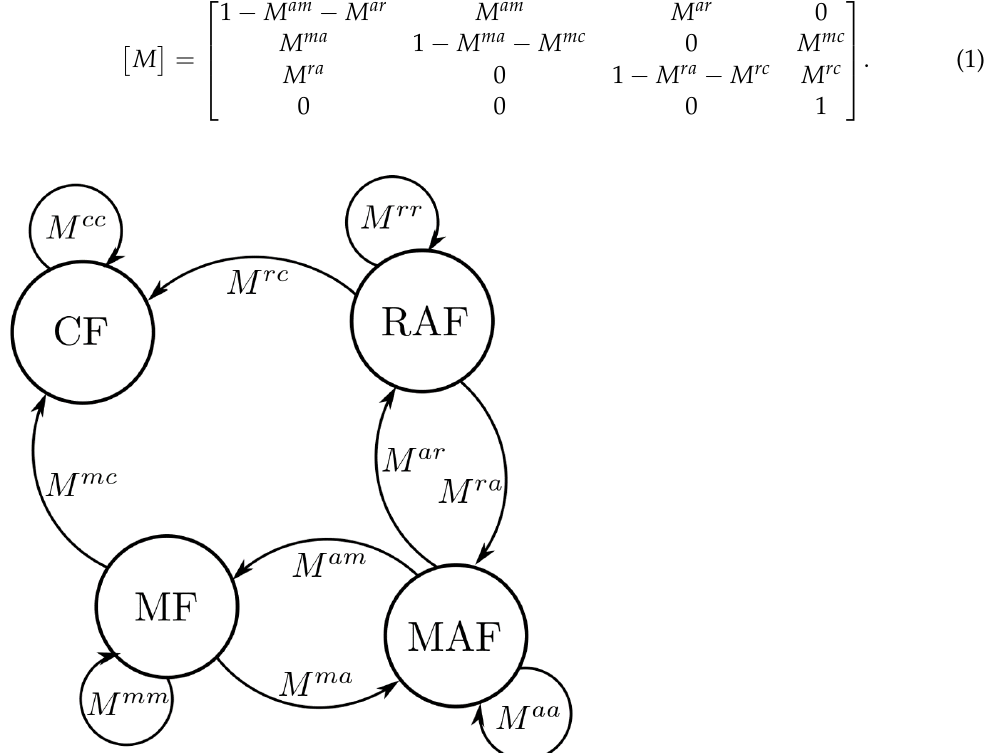
Figure 3. Schematic depiction of the Markov chain. Each arrow depicts a possible phase conversion and the corresponding entries of the Markov matrix are displayed next to the